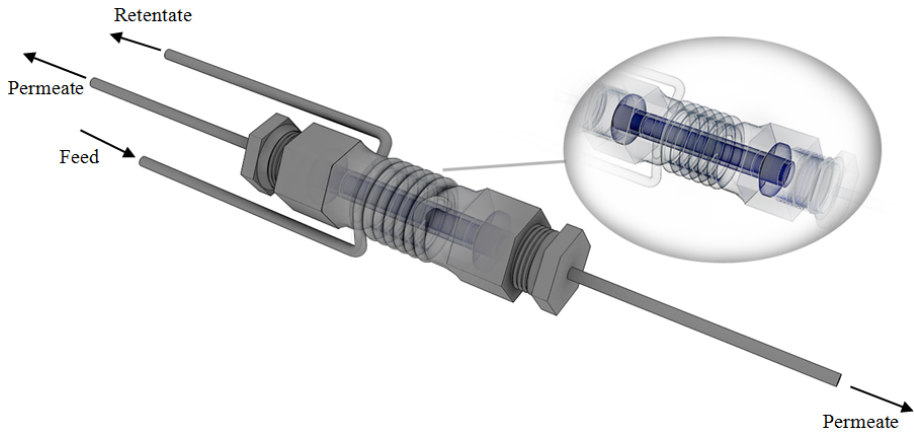
Figure 2. Scheme of membrane module housing the Pd/Al